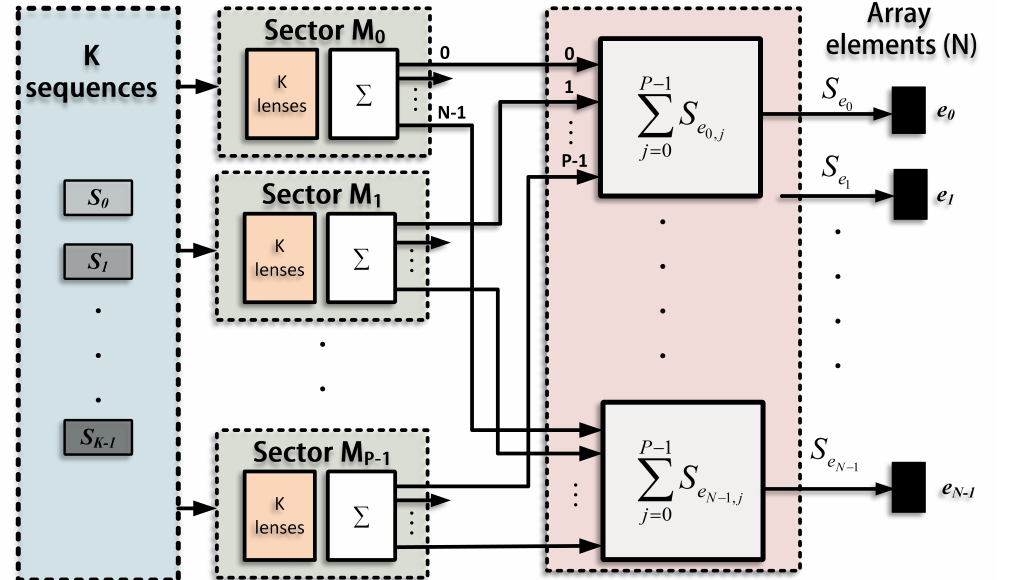
Figure 4. The ePA emission stage, where the image is divided into P sectors sec ( M ), each one explored by emitting K sequences ( S j =0 , 1 ,...,P − 1 every sector ( S ) are added to obtain the final signal to be transmitted by e n =0 , 1 ,...,N − 1; j =0 , 1 ,...,P − 1 each element ( S e n =0 , 1 ,...,N − 1